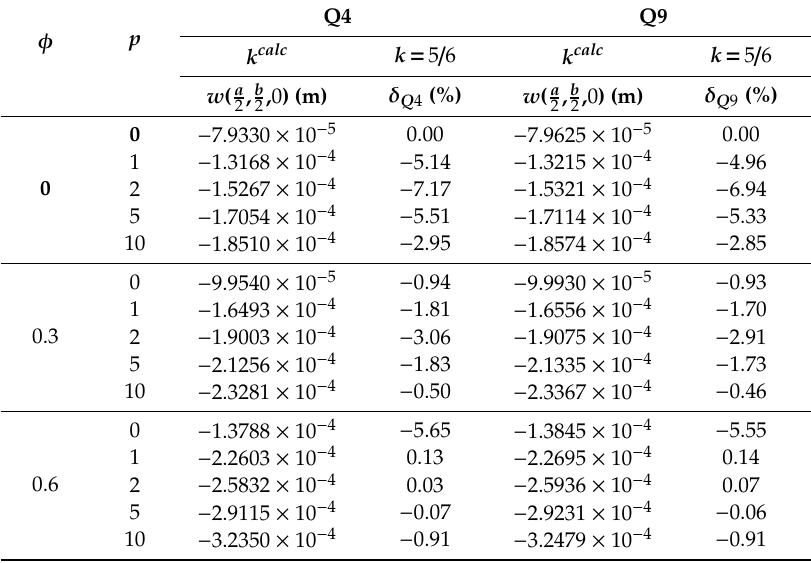
Table 6. Porosity distribution model M1: plates center transverse displacement for di ff erent finite models and shear correction factor